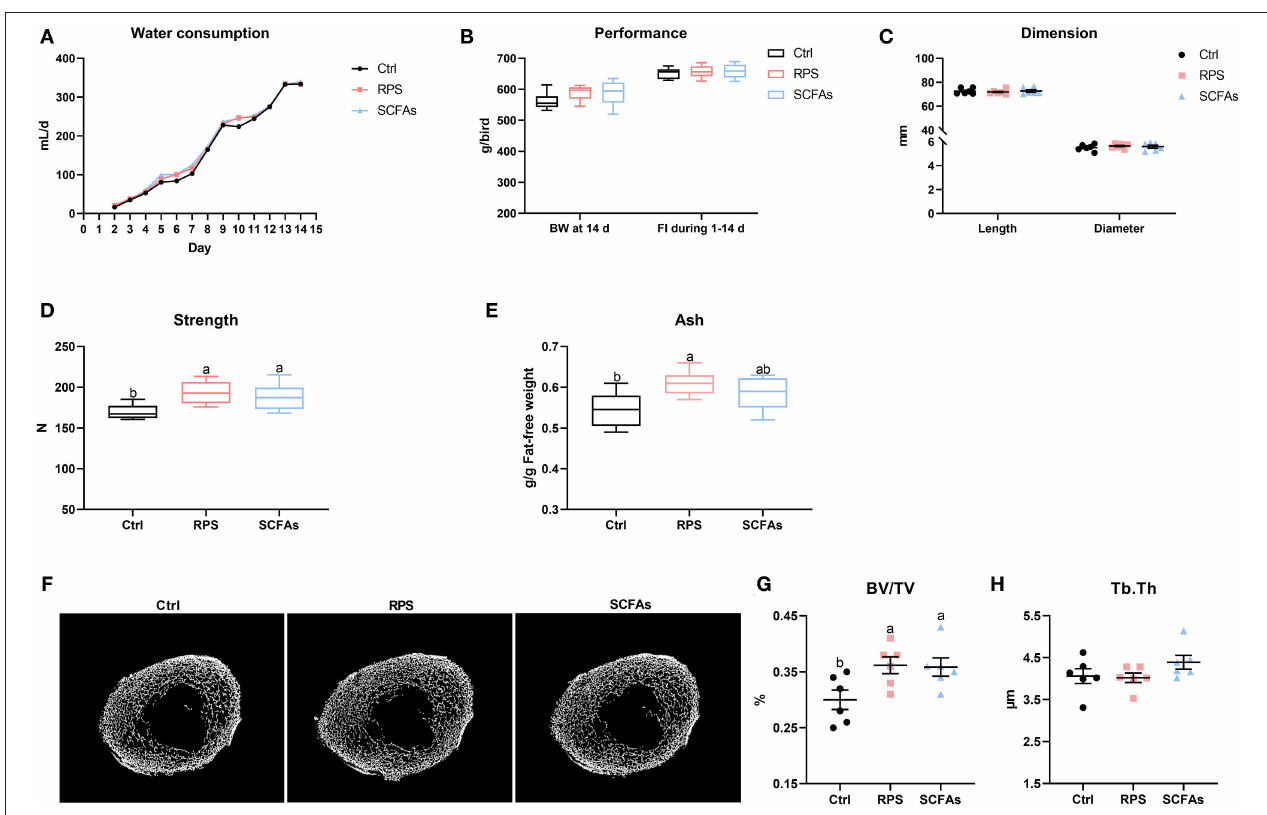
FIGURE 2 | Dietary RPS and drinking short chain fatty acids (SCFAs) addition improve tibia mass in meat ducks. (A) Water consumption, (B) performance including body weight at 14 day and feed intake during 1–14 days, and (C) tibia length and diameter were determined. The bone quality was indicated by (D) tibia strength and (E) ash. (F) Representative micro CT images and the quantification of (G) bone volume/total volume (BV/TV) and (H) trabecular thickness (Tb.Th) of the proximal tibia. Data are expressed as mean and standard deviation. a,b Mean values with different letters are significantly different by one-way analysis of variance followed by Tukey’s post-hoc test ( p <